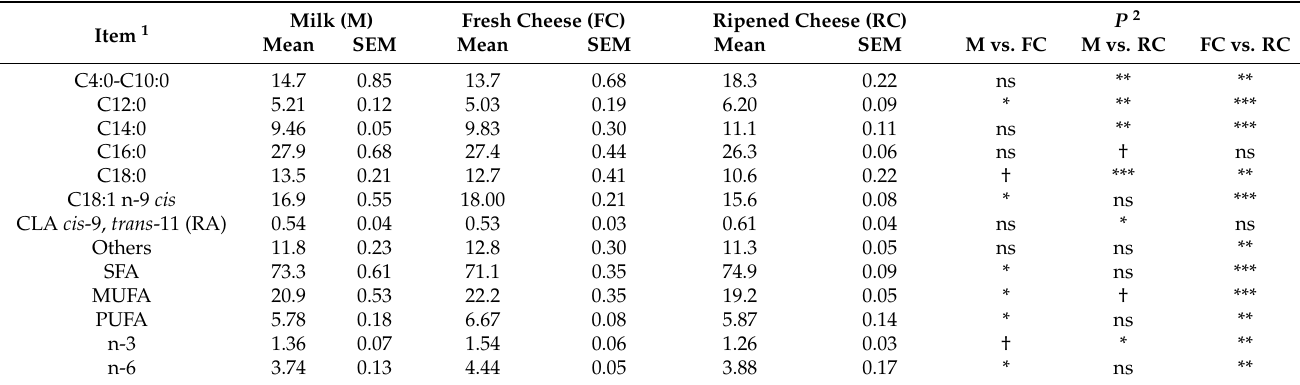
Table 5. Fatty acid (FA) profile (expressed as % of total FA) of fresh and ripened Roja Mallorquina ewes’ cheese and corresponding original milk. Item